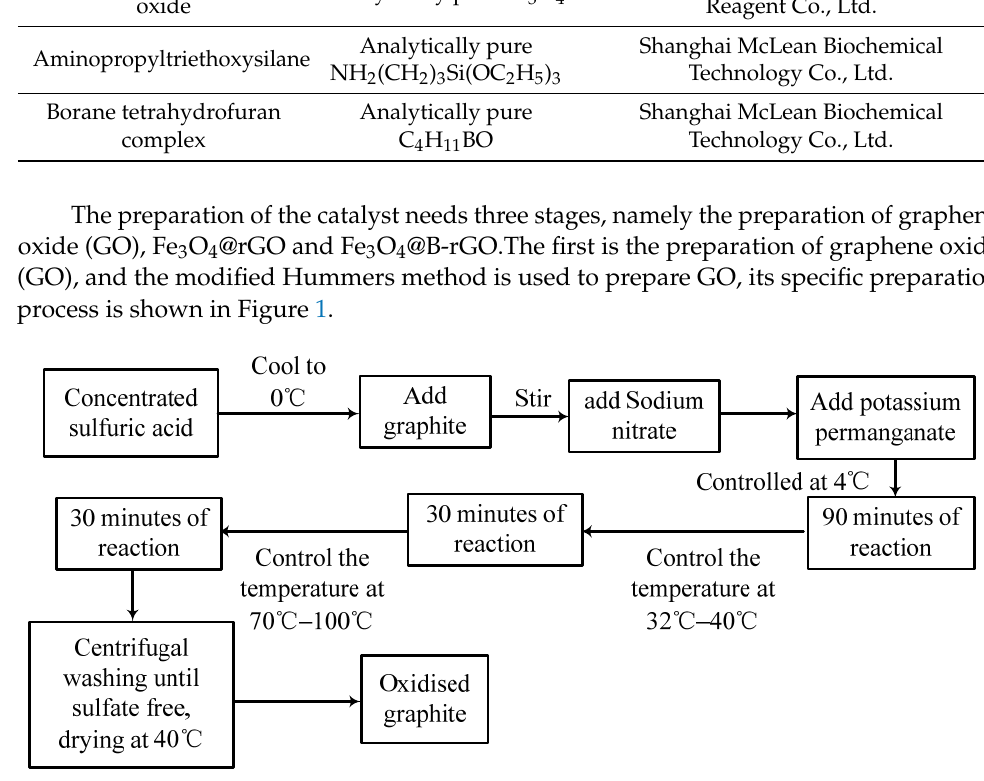
Figure 1. Graphite oxide preparation process technology roadmap.